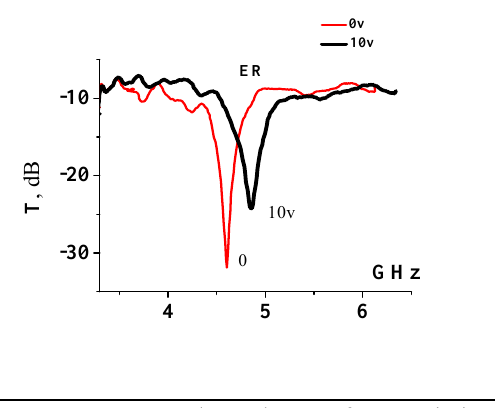
Fig. 16 . Fr equency d ependences of transmission T in the presence of m etastructure “ Grating - varact or loaded sp lit parallel cu t-wire l e ” ( l e = 32mm, l p =16mm, s= 1mm) un der different bi as co nditions i n free spac e Split lo ngitudinal cu t-wire is lo aded with varactor di ode